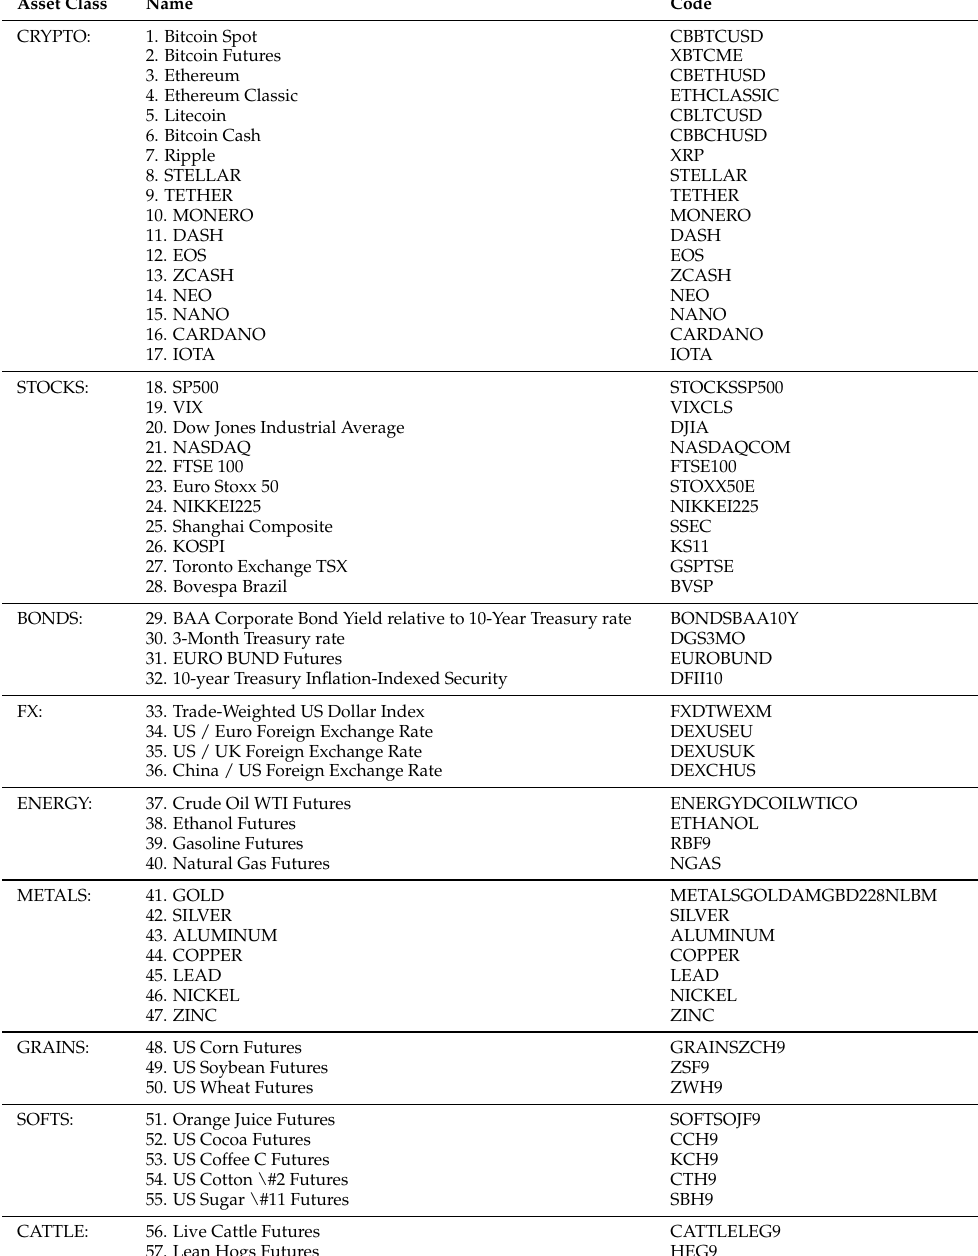
Table 1. Database of crypto-assets, stocks, bonds, fiat-currencies and